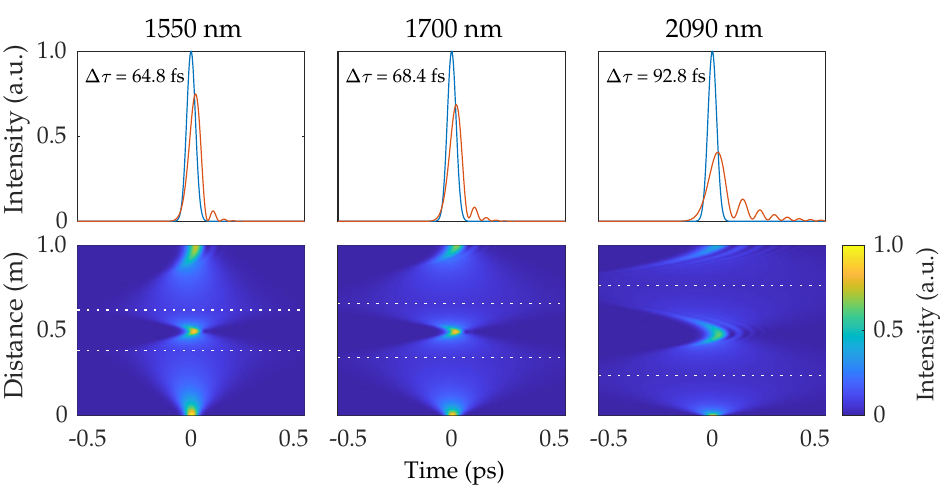
Figure 5. Top row: pulse temporal intensity before (blue) and after (red) propagation through SMF-28 and UHNA4. Bottom row: evolution of the temporal intensity profile through the system of cascaded fibers. White lines indicate transitions between different